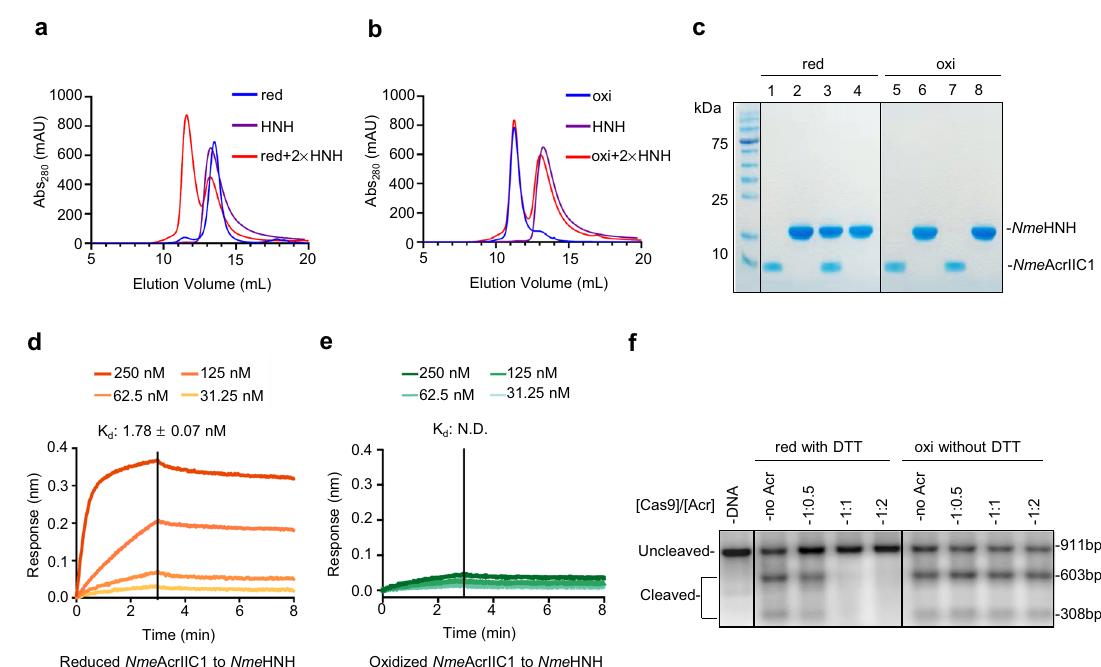
Fig. 2 | The oxidized Nme AcrIIC1 loses its inhibitory activity against Cas9. a Elution pro fi les of the SEC binding assay for the reduced Nme AcrIIC1 (blue), Nme HNH (purple), or the two incubated together with twofold excess Nme HNH (red). The concentration for each trace was normalized to 0.1mM of a single pro- tein. b Elutionpro fi lesof theSECbindingassayfortheoxidized Nme AcrIIC1(blue), Nme HNH (purple), or the two incubated together with twofold excess HNH (red). c Fractions from the assays shown in a , b were visualized on a 12% SDS-PAGE gel. Lane 1 to 4 corresponds to reduced Nme AcrIIC1, Nme HNH, the complex fraction from the mixture of reduced Nme AcrIIC1 with twofold excess Nme HNH, and the residual Nme HNH from the mixture above. Lane 5 to 8 corresponds to oxidized